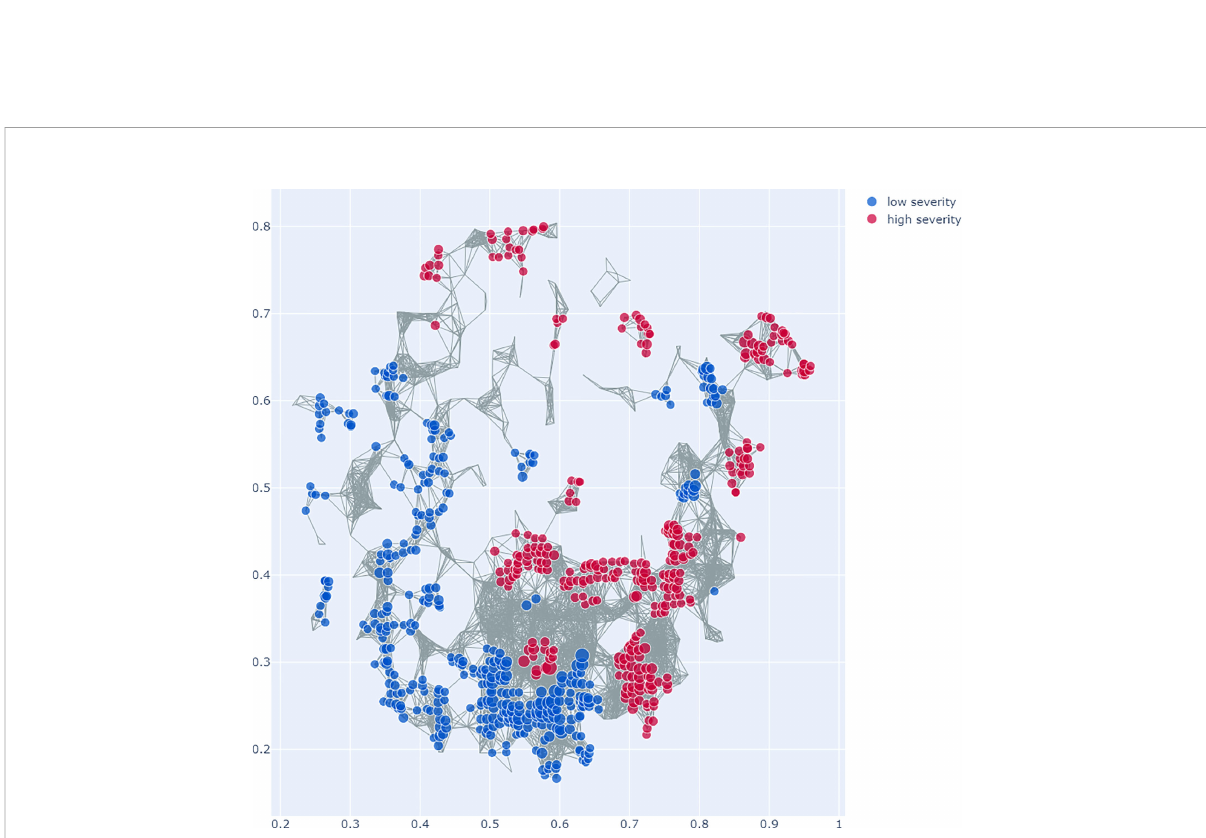
FIGURE 5 Top genus-level bacteria separating low and high COVID-19 groups. The bars towards the right represent higher abundance in the low COVID- 19 group whilst the bars towards the left indicate higher abundance in the high COVID-19 groups. The x-axis in this fi gure displays the logarithmic change of bacteria which differed signi fi cantly.